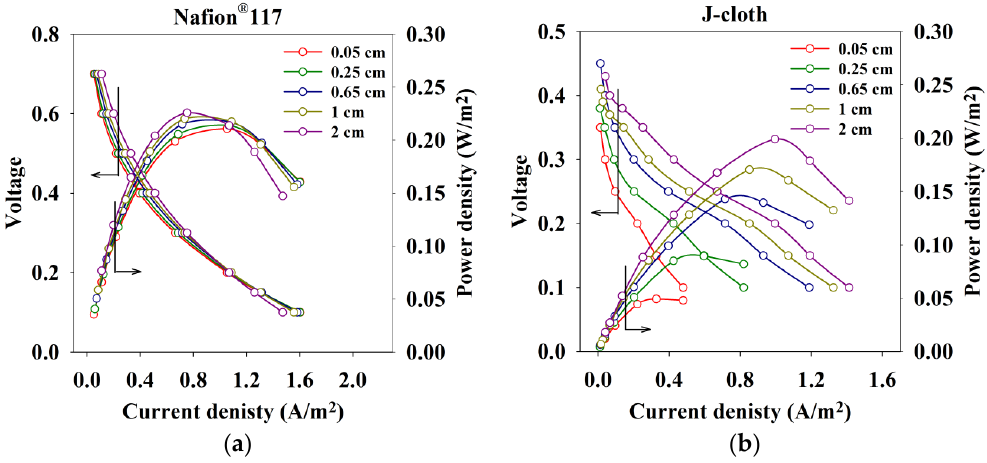
Figure 3. Sensitivity of polarization and power density curves to the electrode spacing using Nafion ® 117 ( a ) and J ‐ cloth ( b ).